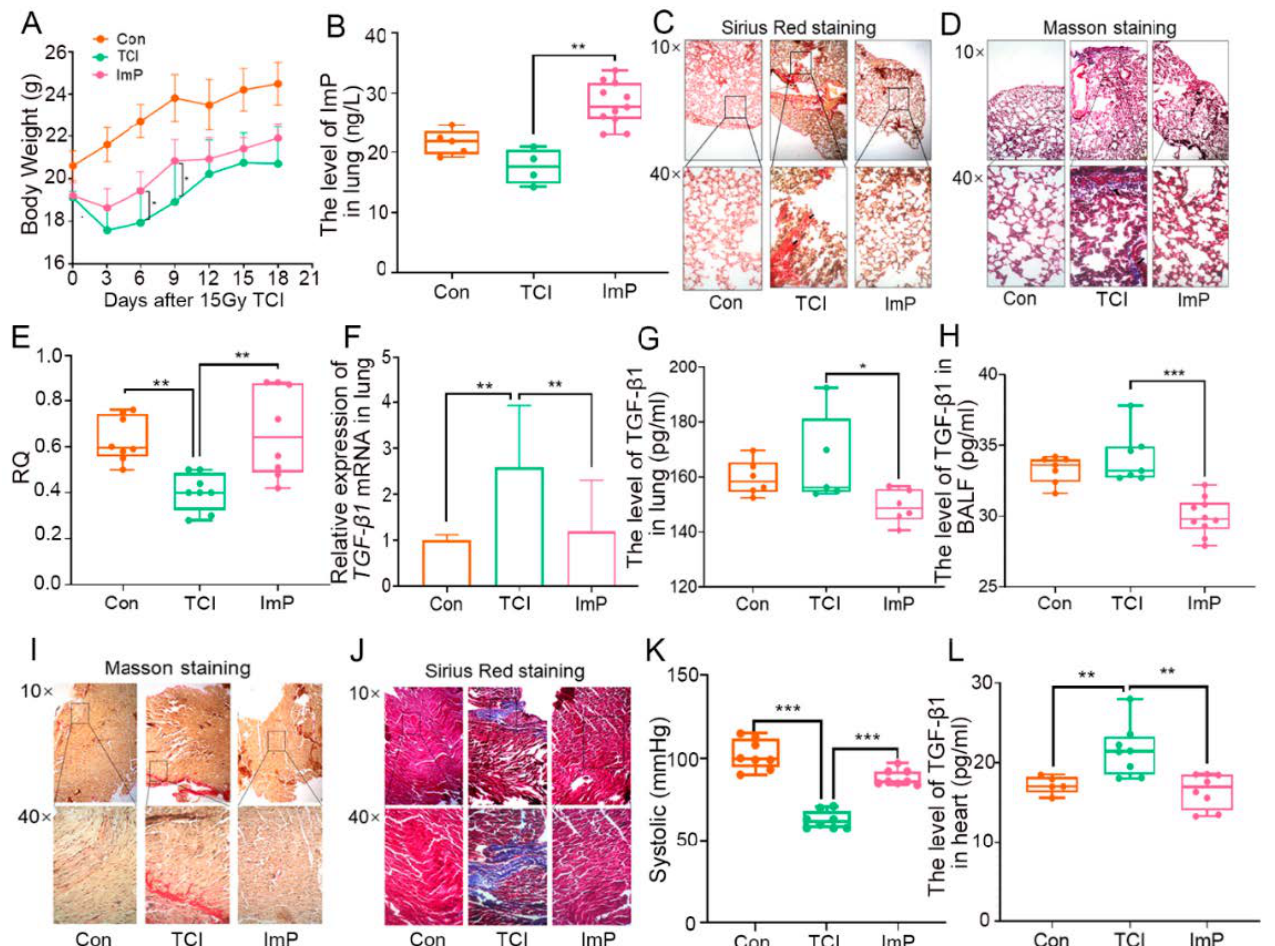
Figure 5. Imidazole propionate ameliorates chest local irradiation-induced toxicity. ( A ) Body weight of mice after 15 Gy. ( B ) The ImP expression in lung tissues by ELISA ( n ≥ 6). ( C , D ) The lung tissues of each group mice were stained with Sirius Red ( C ) and Masson ( D ) and were observed under 10 × and 40 × microscopes, respectively. ( E ) Respiratory quotient (RQ) of mice in each group mice in 24 h ( n = 8). ( F , G ) The TGF- β 1 levels in lung tissues of each group mice were assessed by q-PCR and ELISA ( n = 6). ( H ) The TGF- β 1 levels in the BALF of each group of mice were assessed by ELISA ( n = 8). ( I , J ) The heart tissues of each group of mice were stained with Sirius Red ( I ) and Masson ( J ) and were observed under 10 × and 40 × microscopes, respectively. ( K ) The systolic of each group of mice ( n = 8). ( L ) The TGF- β 1 levels in heart tissues of each group mice were assessed by ELISA ( n = 8). (The data are presented as mean ± SD, * p < 0.05, ** p < 0.01 and *** p < 0.001; Student’s t -test.).